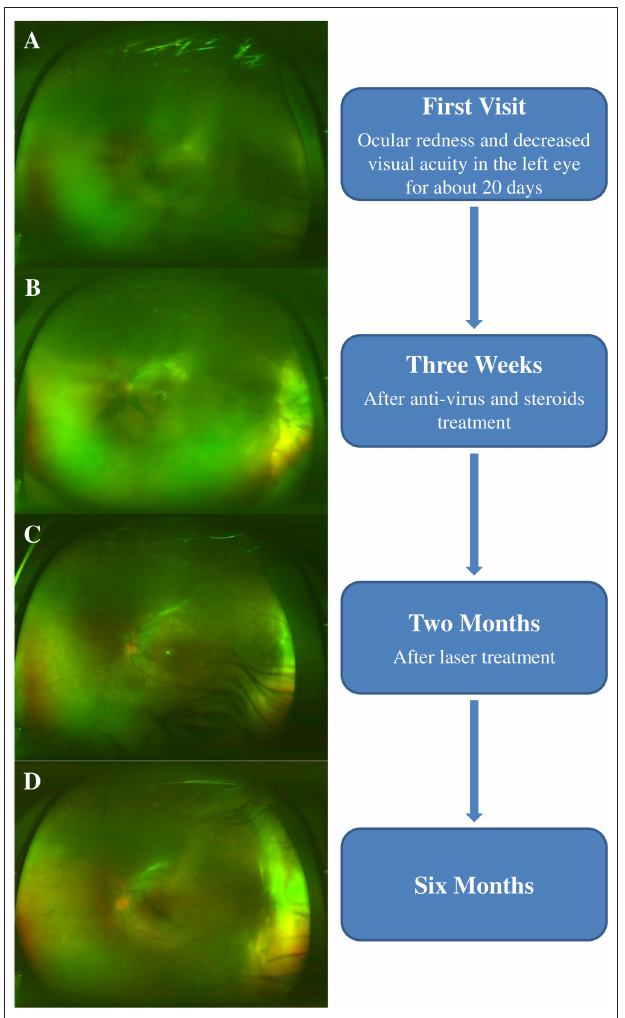
FIGURE 2 | (A) At the initial examination, the fundus could not be inspected due to vitreous opacity. (B) After 3 weeks of antiviral and steroid treatment, the fundus could be gradually observed. Wide-field fundus photography revealed optic disc edema, macular edema, and peripheral retinal necrosis. (C) At the 2-month follow-up, peripheral retinal proliferation was observed in the fundus examination; thus, the patient was provided prophylactic laser treatment. (D) At the last follow-up, wide-field fundus photography revealed the attachment of the retina.